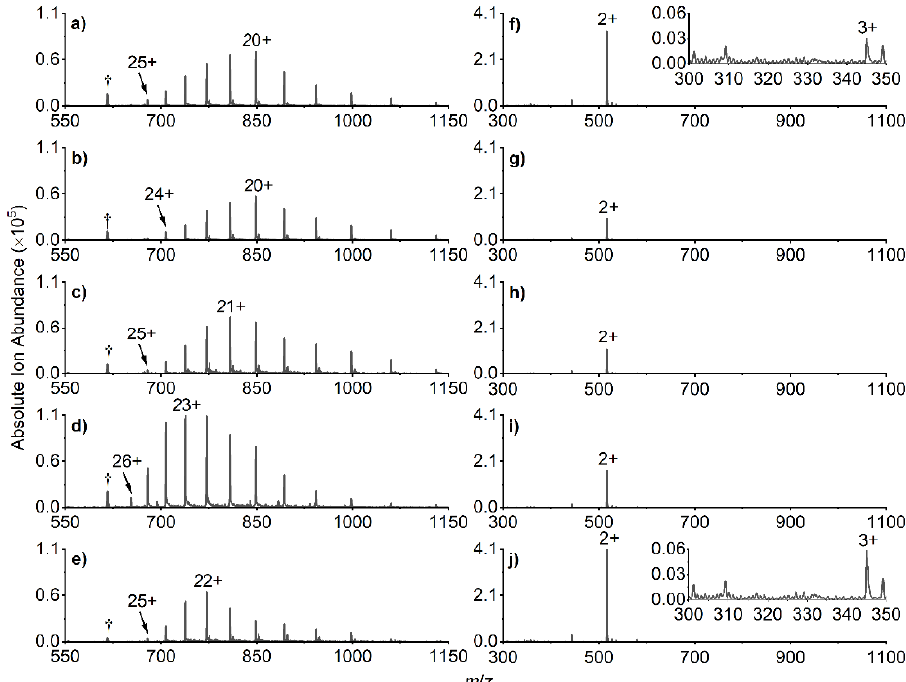
Figure 3. Mass spectra of myoglobin (5 µM) ( a – e ) and angiotensin II (1 µM) ( f – j ) obtained from pulsed and conventional direct current nESI methods. ( a , f ) Conventional direct current nESI mass spectra of myoglobin and angiotensin II. ( b – e ) Pulsed nESI mass spectra of myoglobin obtained using a frequency of 50, 100, 200 and 300 kHz, respectively. ( g – j ) Pulsed nESI mass spectra of angiotensin II obtained using a frequency of 50, 100, 200, and 250 kHz, respectively. All pulsed nESI experiments were conducted using a duty cycle of 50%. † The heme group of myoglobin.